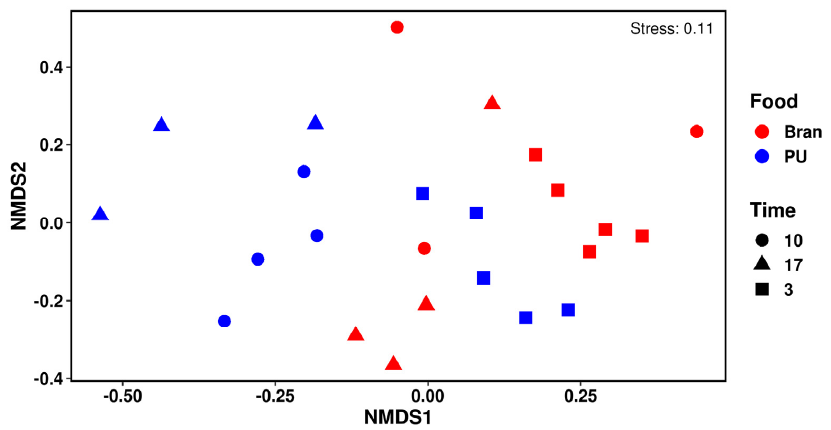
Figure 6. The NMDs of the gut microbial community for both diets (PU and bran) at different sam- pling times (3, 10, and 17 days).